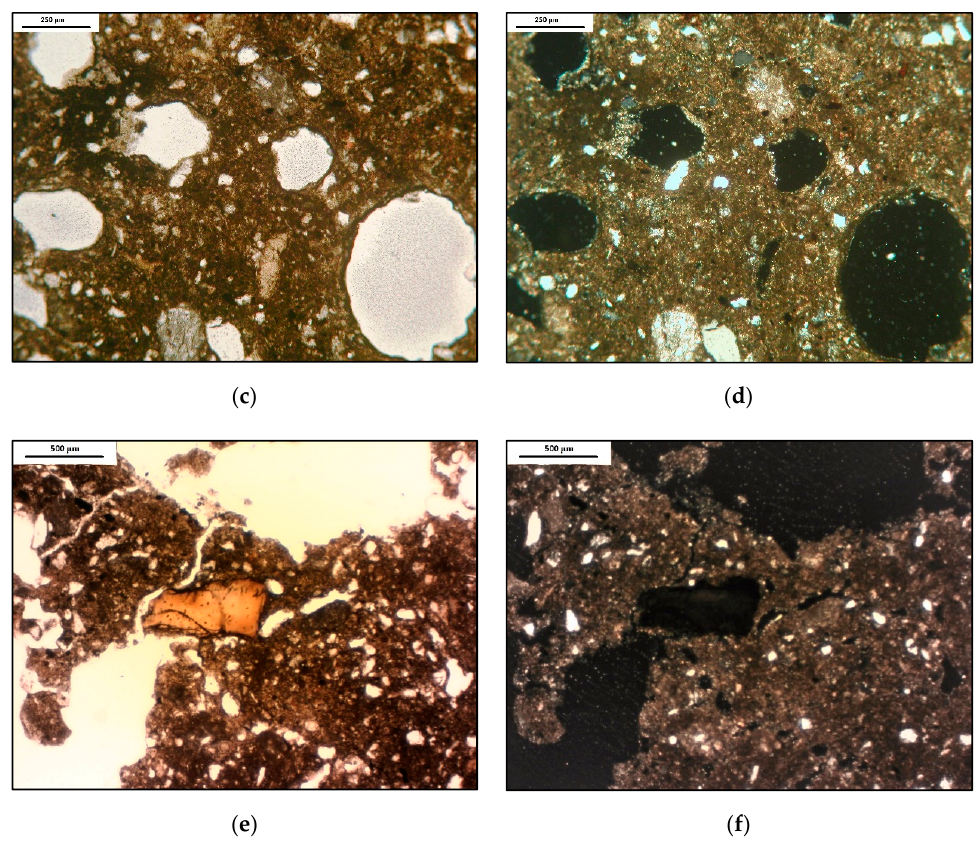
Figure 5. Microphotographs of some relevant features in MTB1. ( a , b ) The platy structure and the